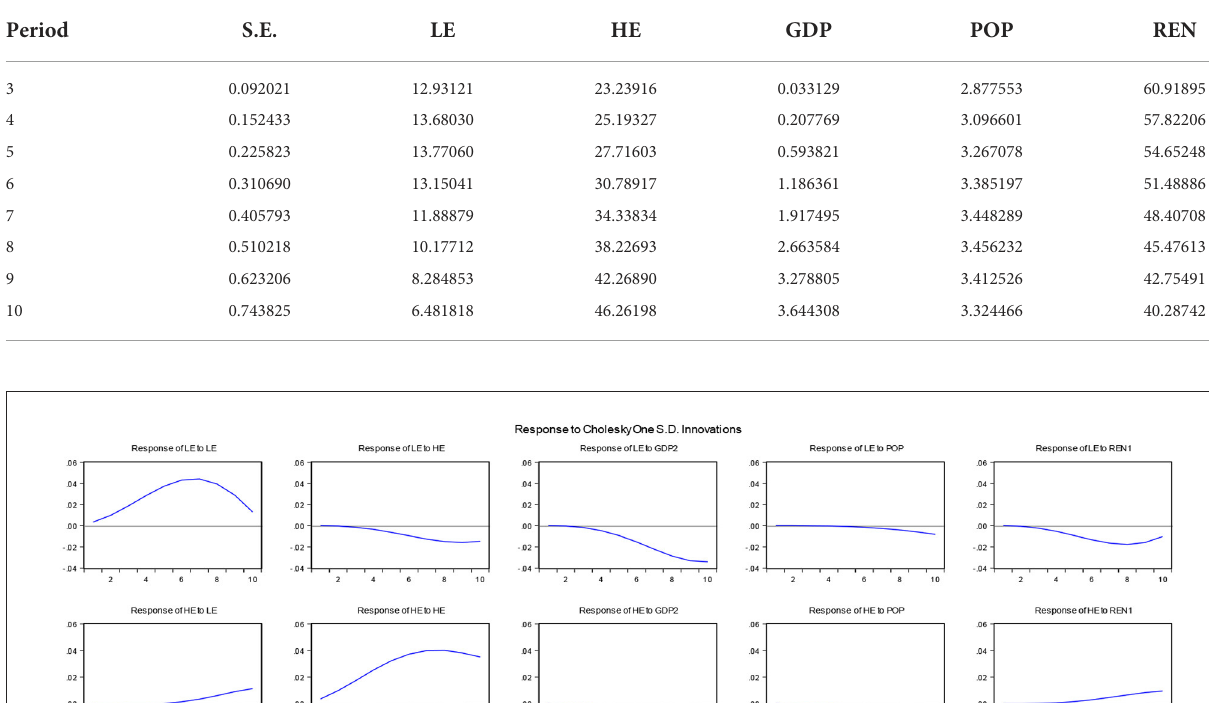
in China. model. Wald test estimations present the short run causality, while the lag value of ECT shows the long run causality. The